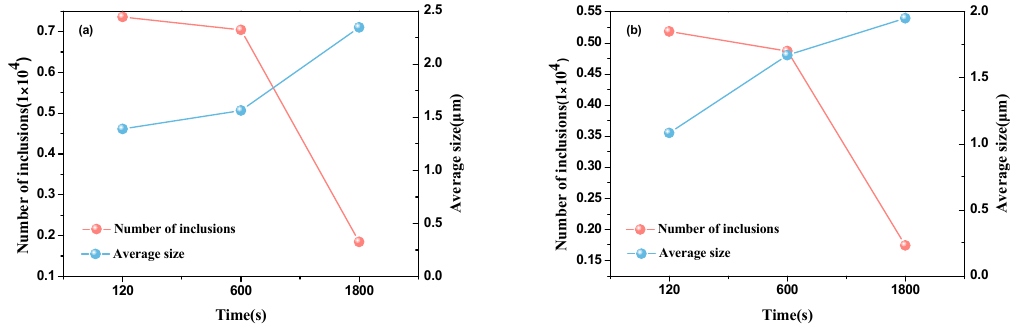
Figure 4. The number and the average size of inclusions as function of holding time. ( a ) Al deoxidation, ( b ) Al-Mg complex deoxidation.